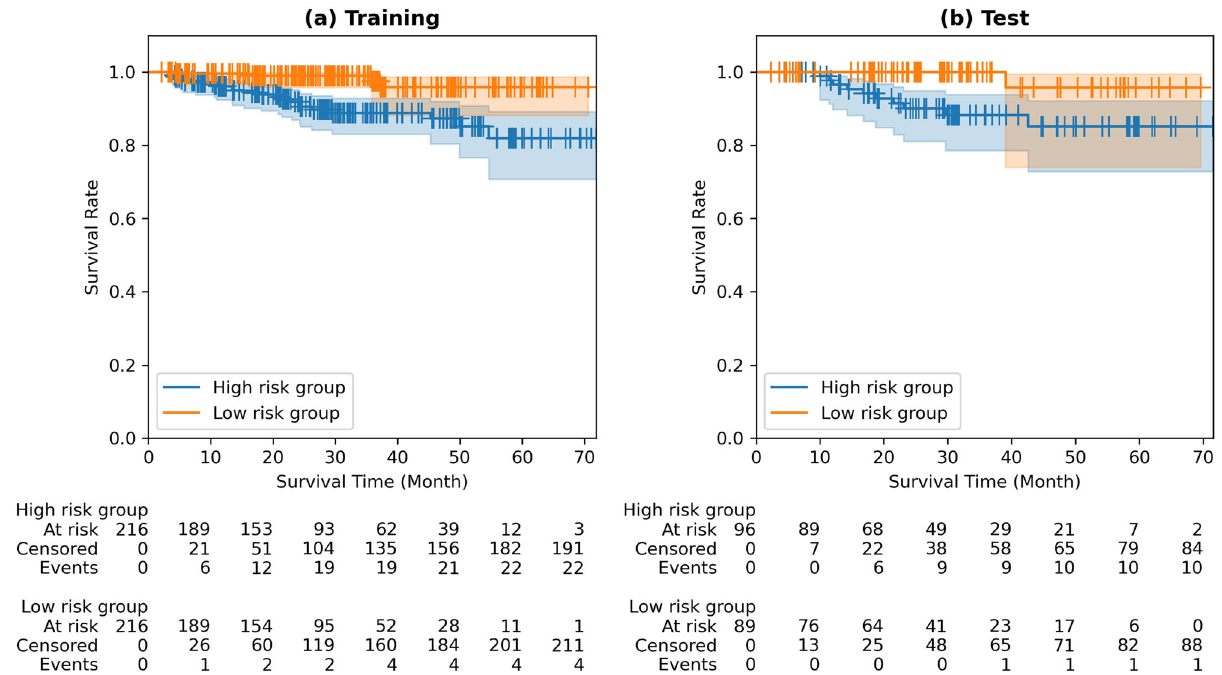
Fig. 2 Kaplan – Meier plots of the baseline radiomics model. a Kaplan – Meier plot of training cohort, hazard ratio of 4.1384 (95% CI of 1.9140 – 8.9479), p -value of 0.0006, C-index of 0.7459. b Kaplan – Meier plot of test cohort, hazard ratio of 5.0566 (95% CI of 1.5379 – 16.6263), p -value of 0.0180, and C-index of 0.6837. Table 2 Performance of various radiomics-guided DL models.